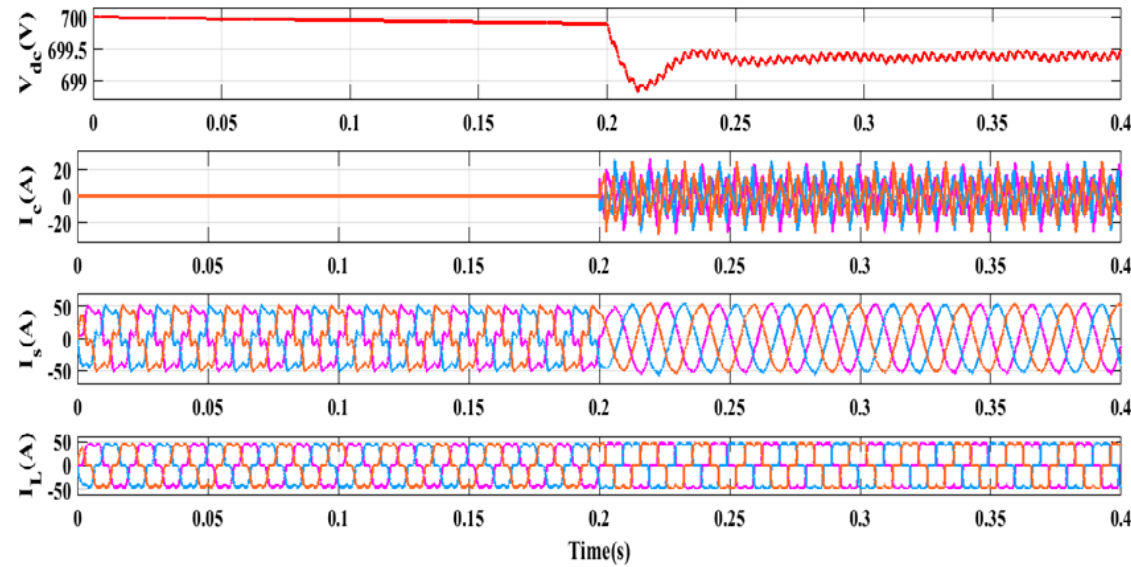
Figure 22. Performance of Icos θ -based DSTATCOM with electric arc furnace-based non-linear load.